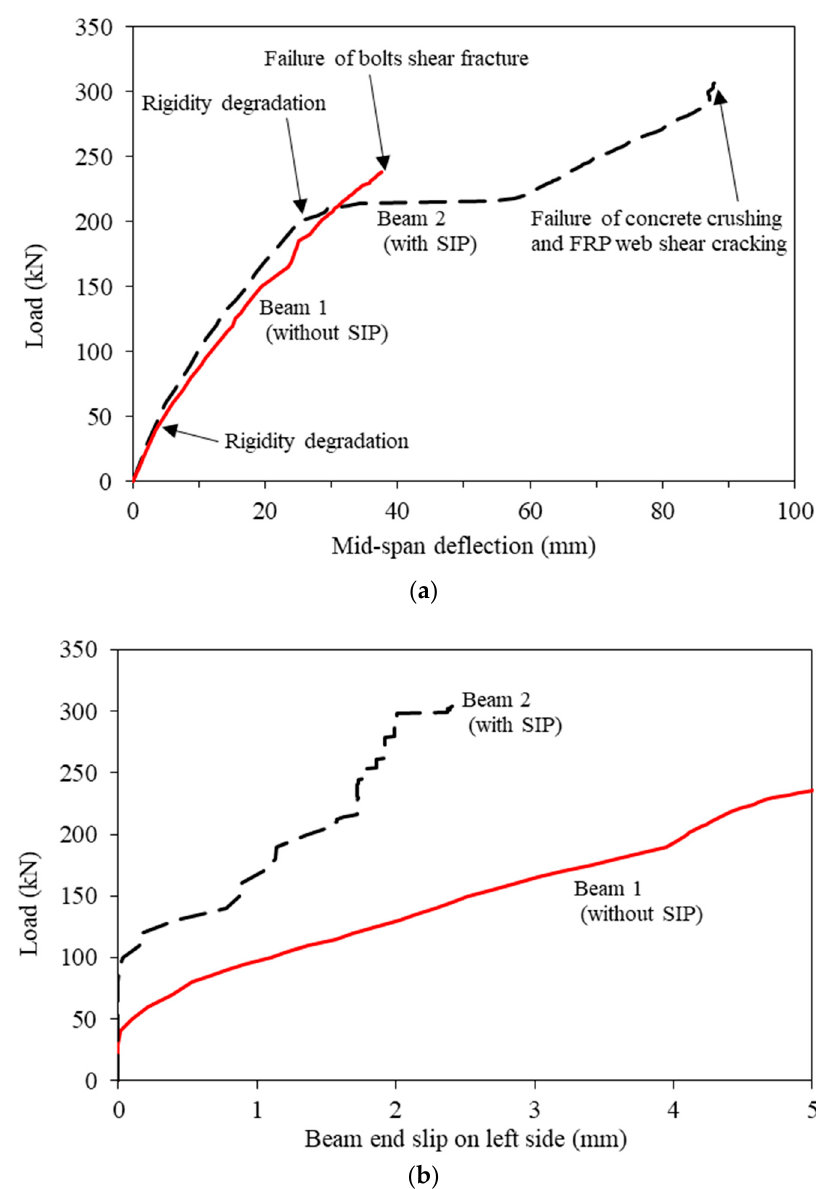
Figure 6. Comparison of Beams 1~2: ( a ) Mid-span deflection; and ( b ) Beam end slip on the left side.